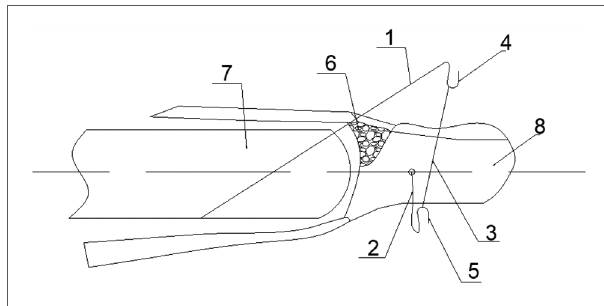
FIGURE 3 Follow-up of patient No. 4. ( A,B ). X-ray at 6 weeks postoperatively. ( C, D ). X-ray at 22 weeks postoperatively. ( E,F ). Finger appearance at 22 weeks.